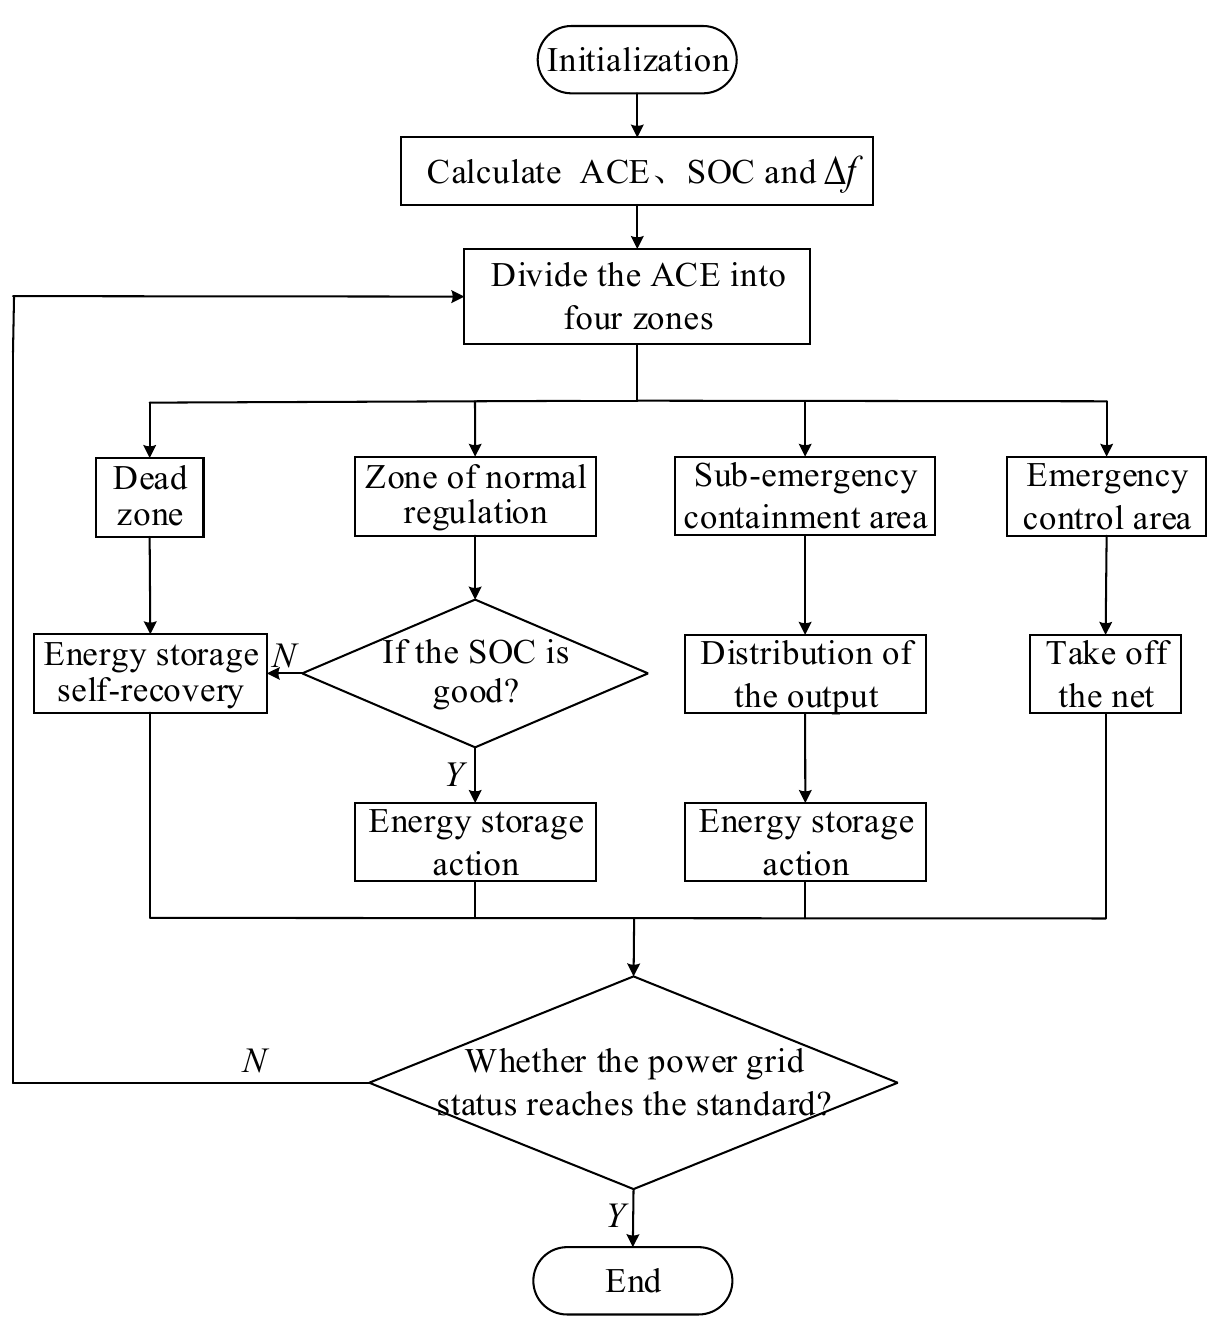
Figure 6. Flowchart of the control strategy.